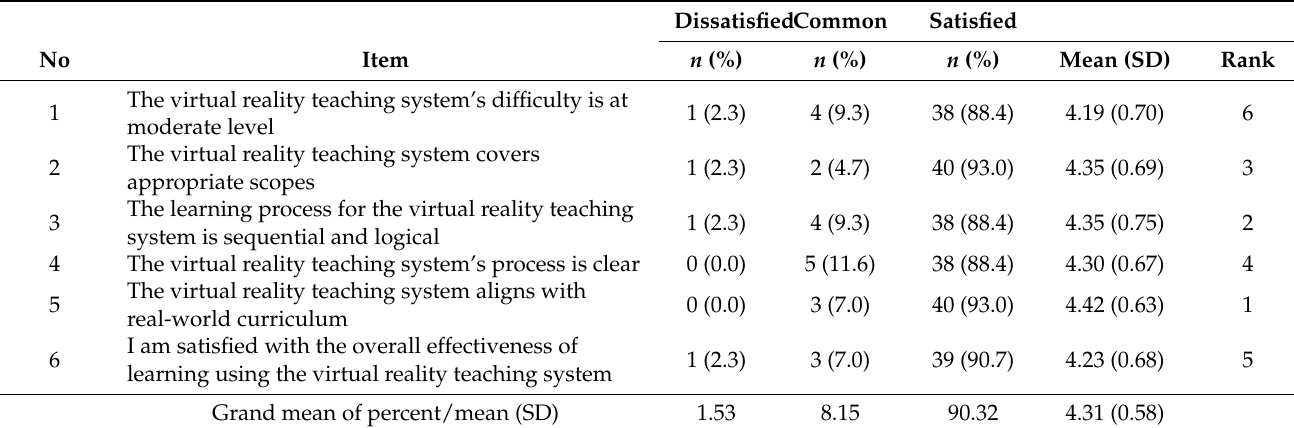
Table A2. Satisfaction distribution of the virtual reality intervention learning system for implanted Port-A catheter care ( n =